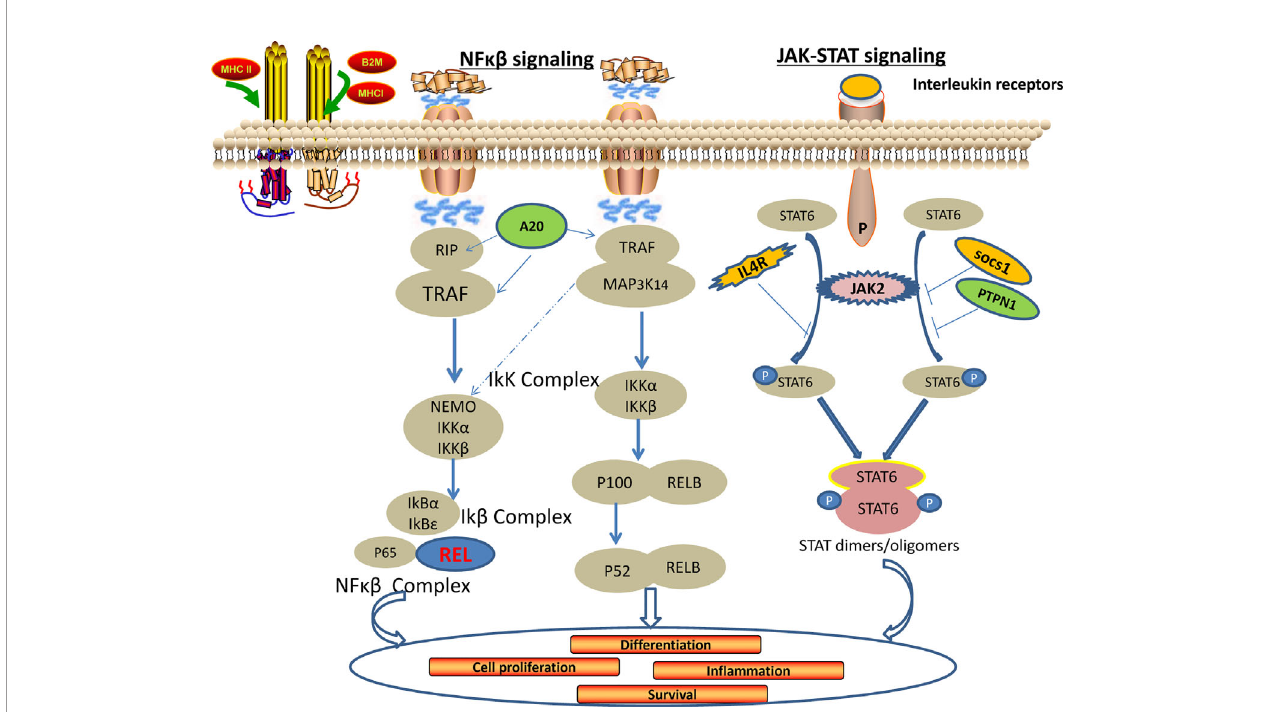
FIGURE 1 | A popular signaling pathway in the research of primary mediastinal large B-cell